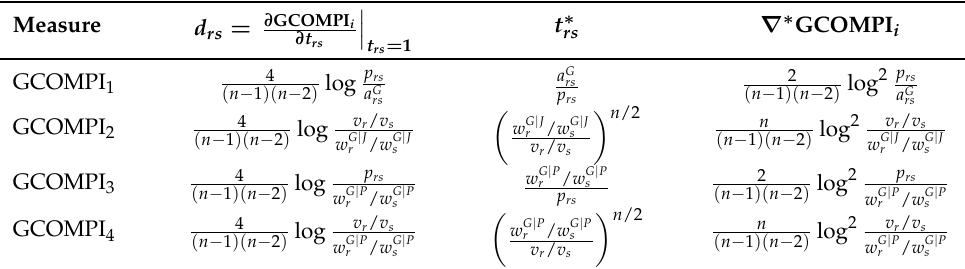
Table 1. Values from theoretical results for the